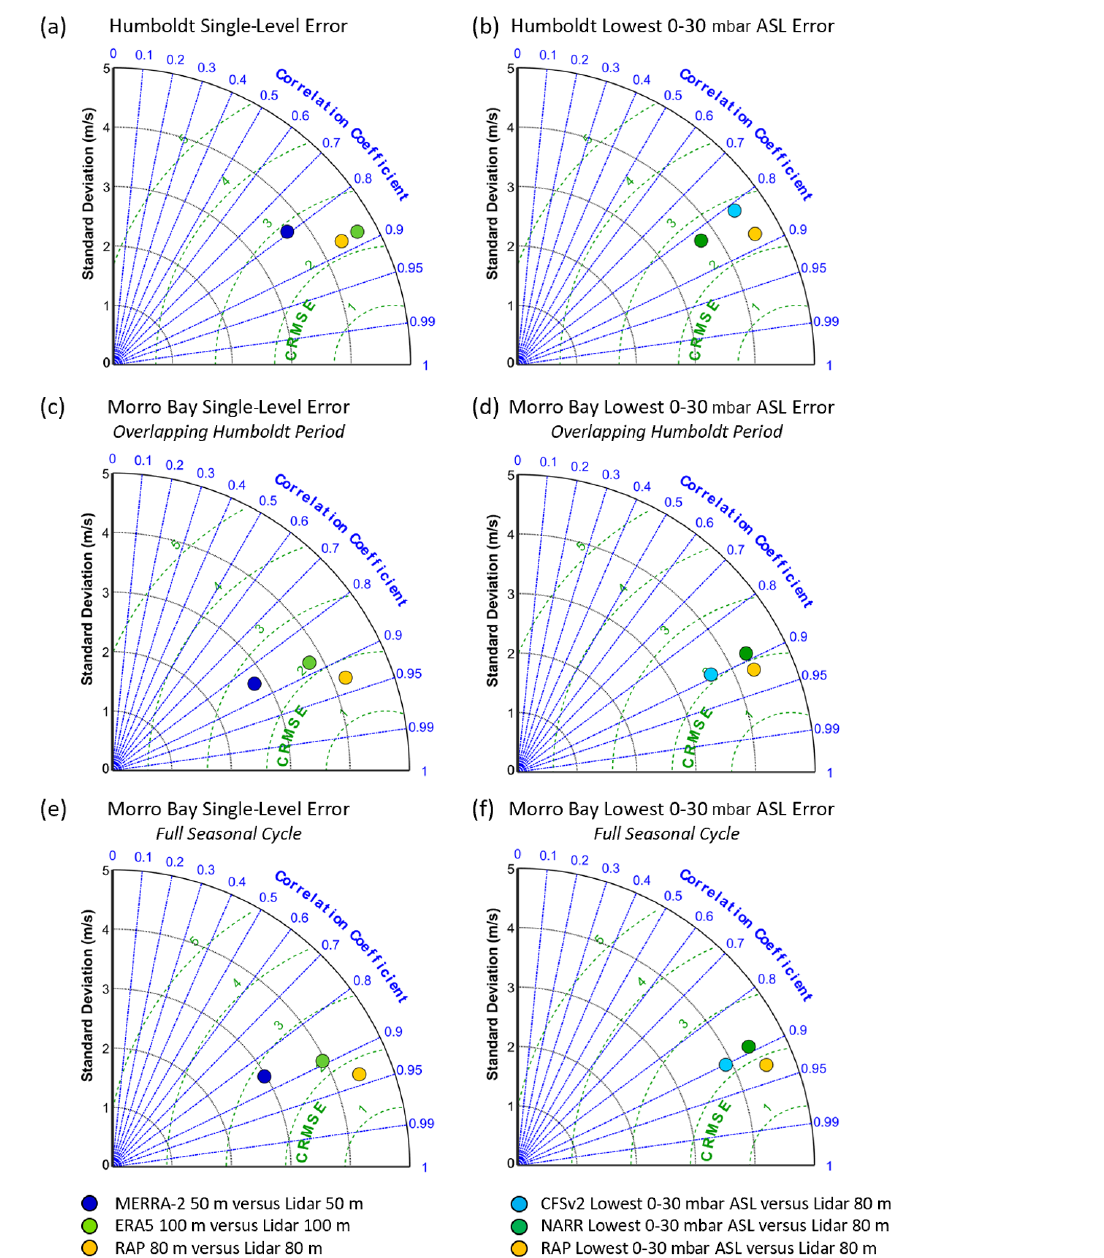
Figure 7. Taylor diagrams of single-level model error at (a) Humboldt and (c) Morro Bay and error using the lowest 0–30mbar layer above sea level to simulate hub height at (b) Humboldt and (d) Morro